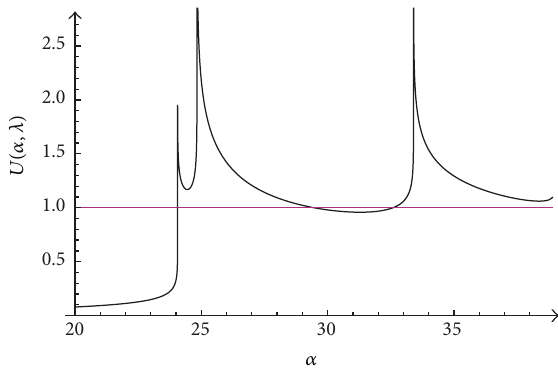
Figure 5: The graph of the function 𝑈(𝛼,0.01) .